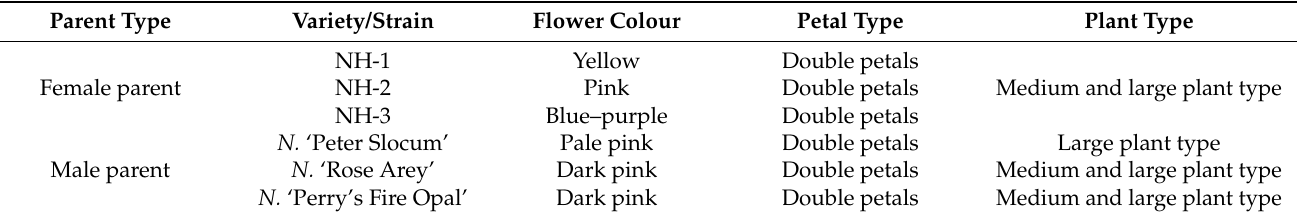
Figure 1. Morphology of the inflorescence of three hardy water lily varieties. ( a ) N. ‘Rose Arey’; ( b ) N. ‘Perry’s Fire Opal’; ( c ) N. ‘Peter Slocum’. Table 1. Materials used for the crossbreeding